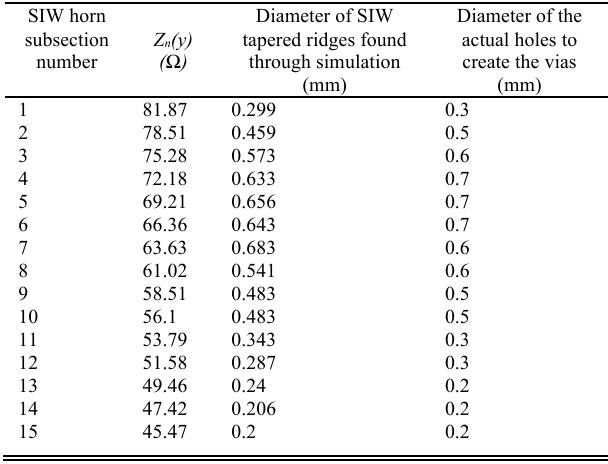
TABLE I. Units for Magnetic